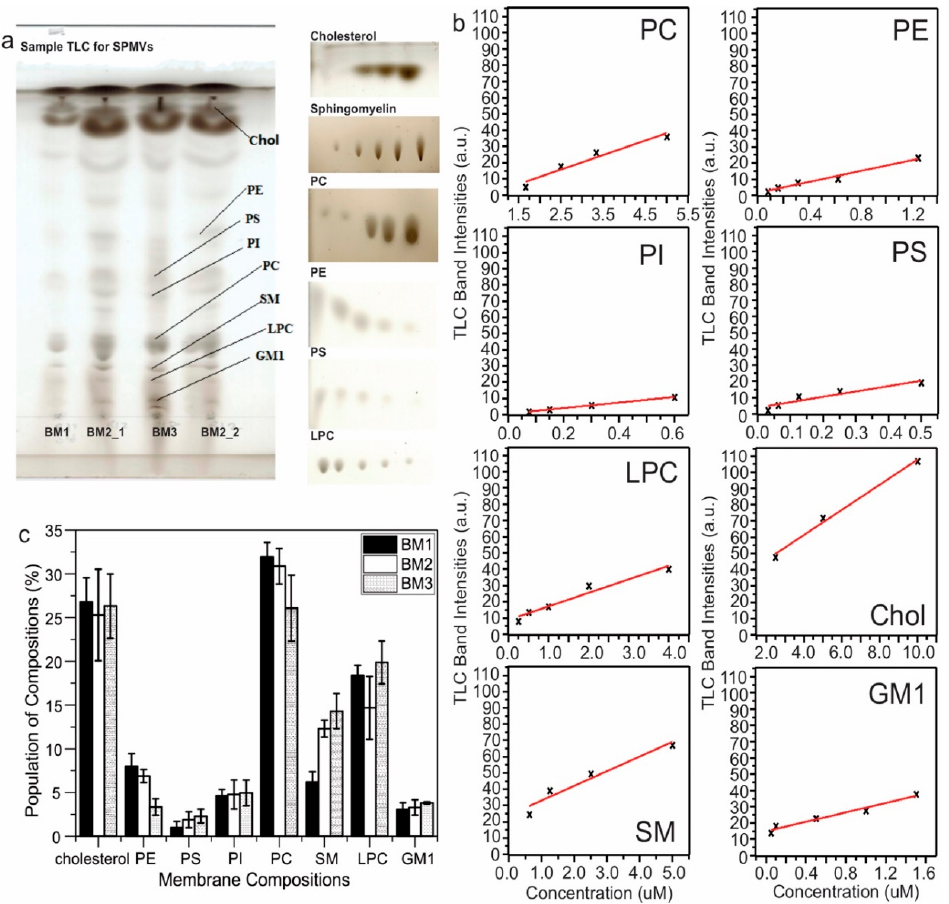
Figure 1. ( a ) Representative Thin-Layer Chromatography (TLC) analysis of the membrane compositions of rats’ synaptic plasma membrane vesicles (rat synaptic plasma membrane vesicles (rSPMV), left side) and TLC for the standard lipids / cholesterol at di ff erent concentrations. ( b ) Standard curves for the quantifications of membrane compositions using TLC. ( c ) Plots of lipid compositions in rSPMV of di ff erent ages. Error bars were generated from three independent TLC